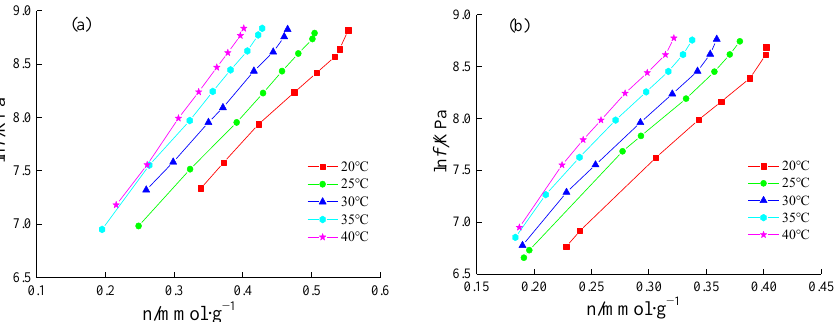
Figure 8. ln f -n relationship of methane adsorption in the desorption experimental: ( a ) vitrain; ( b )